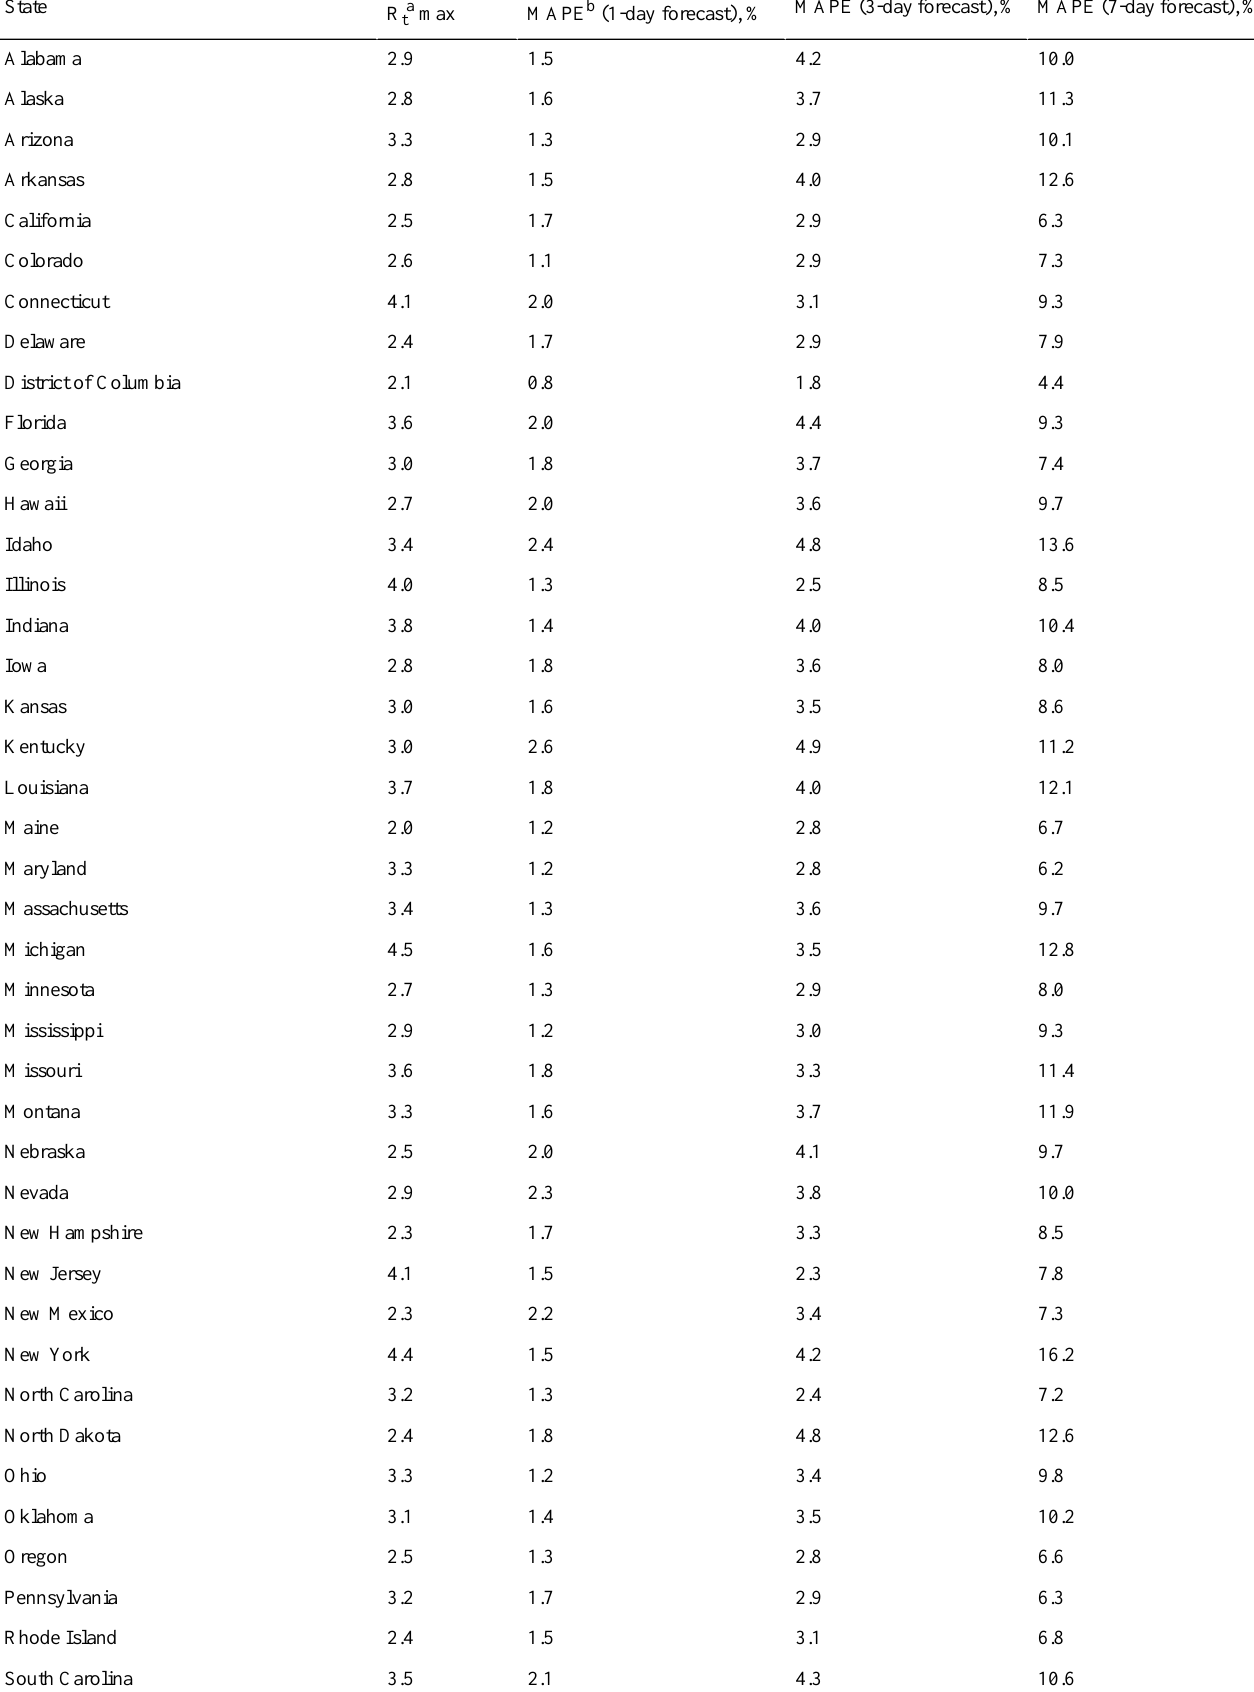
Table 1. Reproduction numbers and forecast accuracy for 50 US